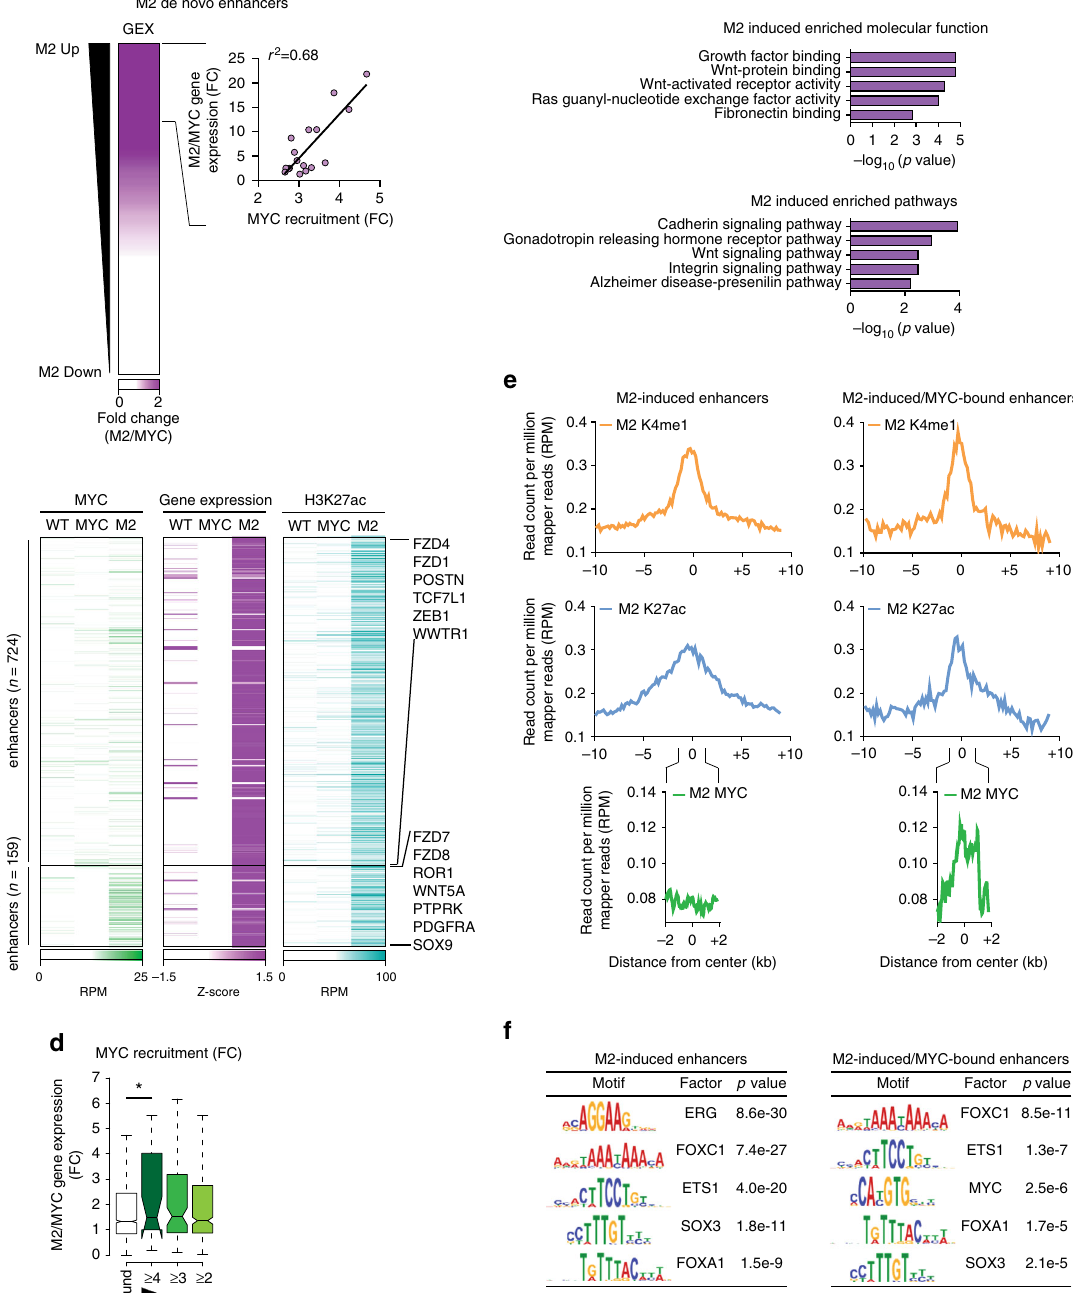
valueM2-induced/MYC-bound Factor p